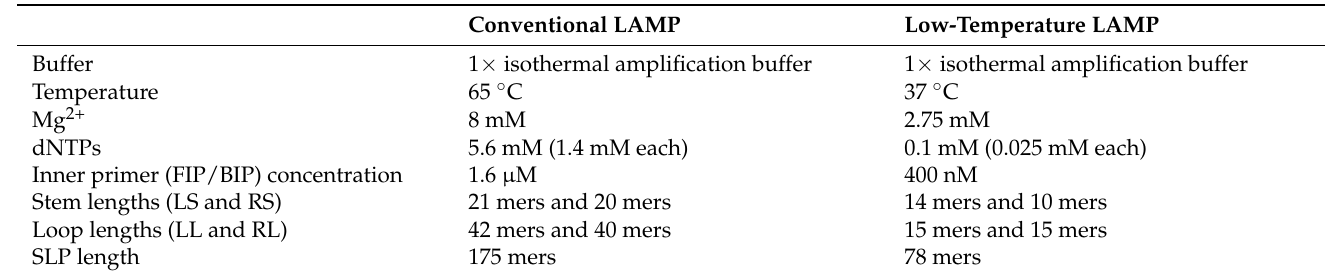
Table 1. Comparison of conventional and low-temperature LAMPs in terms of reaction components, conditions, and SLP lengths. The reaction conditions of conventional LAMP were adopted from the typical LAMP protocol using Bst 2.0 DNA polymerase (NEB) [24].